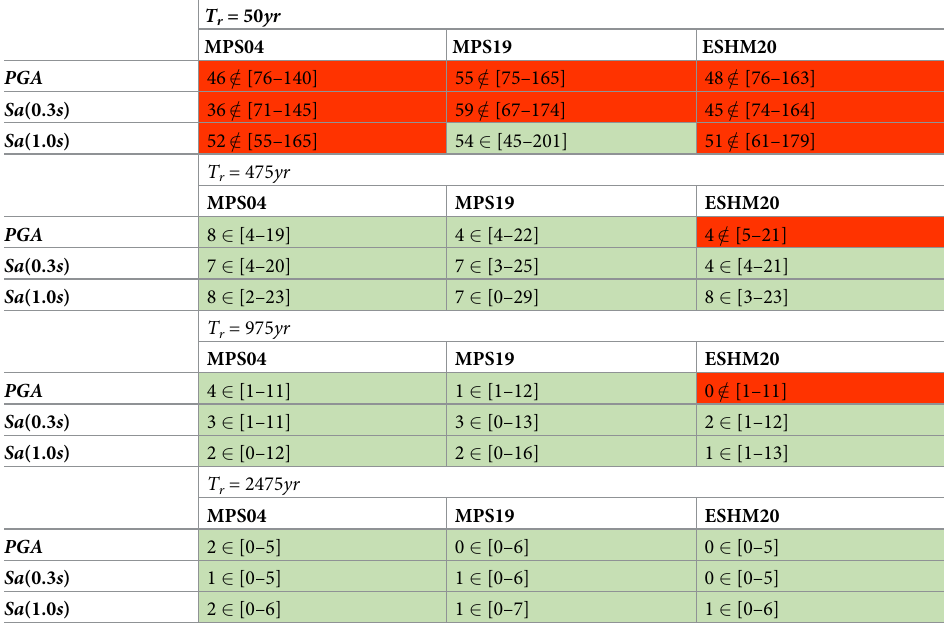
Table 1. Comparison between the non-rejection region and the number of exceedances collectively observed at the stations from 1973 to 2019 for intensity measure, return period, and hazard